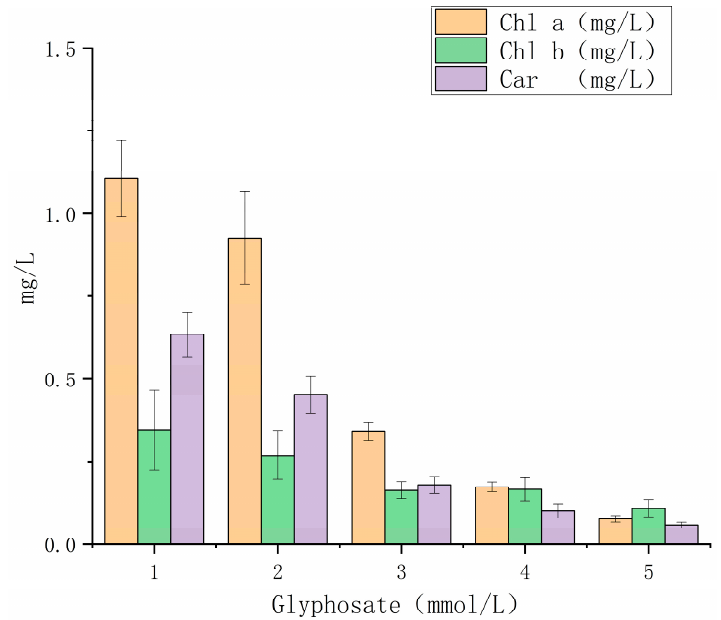
Figure 2. Effects of glyphosate on the photosynthetic pigments of Chlorella vulgaris . Chlorophyll b, as a photo-harvesting pigment of the algal photosynthetic system, plays an important role in photosynthesis. A low concentration of glyphosate (1 mM) ex- hibited a little and insignificant effect on chlorophyll b content compared with the control (Figure 2B). The treatment with glyphosate at concentrations higher than 10 mM signifi- cantly reduced chlorophyll b content, indicating that glyphosate exhibited a certain inhib- itory effect on chlorophyll b synthesis. As an accessory pigment of the photosynthetic system, carotene assists in light ab- sorption and dissipation of excess light energy. A low concentration of glyphosate (1 mM) exhibited little effect on the carotene content, whereas the treatments with medium con- centrations (10 and 20 mM) significantly reduced the carotene content in C. vulgaris (Fig- ure 2C). A high concentration of glyphosate (40 mM) had the greatest effect on carotene content, and the carotene content was less than 1/6th of that in the control. 3.3. The Effects of Glyphosate on Chl a Fluorescence Induction Kinetics As shown in Figure 3, glyphosate exhibited a significant effect on the photosynthetic Chl a fluorescence induction kinetics. The fluorescence intensity values of the treatment groups with glyphosate concentrations above 5 mM were lower than those in the control group, and the O, J, I, and P phases of the low-concentration treatment groups (1 mM and 10 mM) remained normal, while the inhibition of photosynthesis in the high concentration treatment group (20 mM and 40 mM) was obvious, and the induction curve lacked inter- mediate J and I phases, and directly entered the P phase, which indicated that the photo- synthetic electron transmission was seriously damaged by a high concentration of glypho- sate.